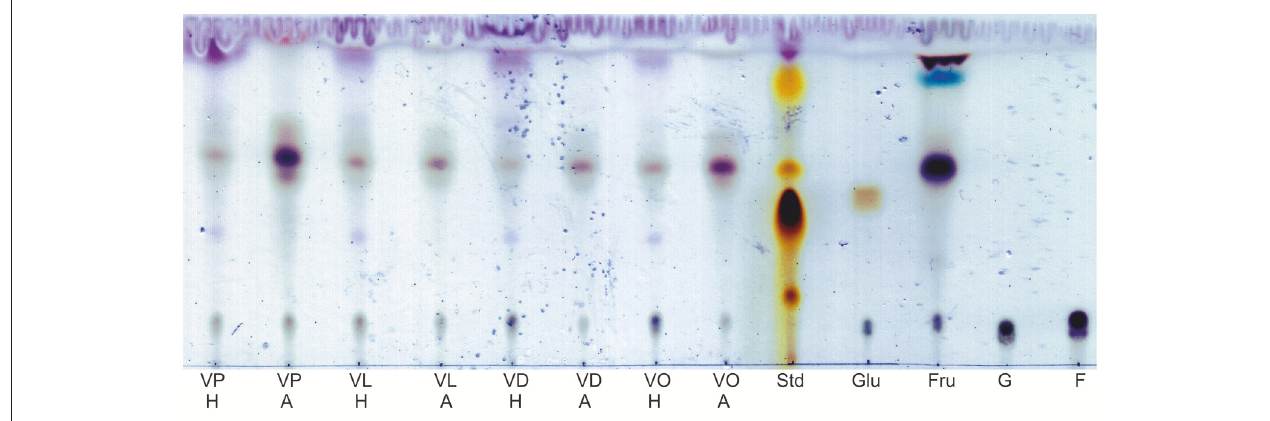
FIGURE 1 | Visualization of synthesized glycolipids in honey and agave syrup after dying with an anisaldeyhde solution. Ten microliters of the extracts and four microliters of the standards were spotted on the TLC plate. VP, vinyl palmitate; VL, vinyl laurate; VD, vinyl decanoate; VO, vinyl octanoate; H, synthesis in honey; A, synthesis in agave syrup; Std, lab intern rhamnolipid standard; Glu, glucose based DES with VO; Fru, fructose based DES with VO; G, glucose, solved in an ethanol-water mixture; F, fructose in an ethanol-water mixture.